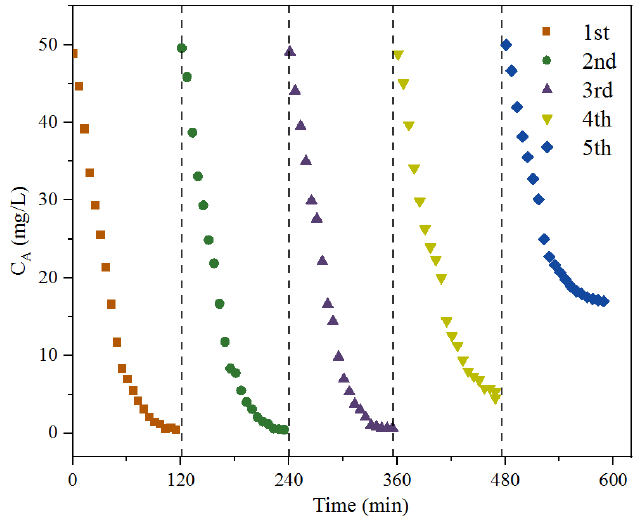
Figure 5. Recyclability of N,Fe-CDs for remediation of S 2−.